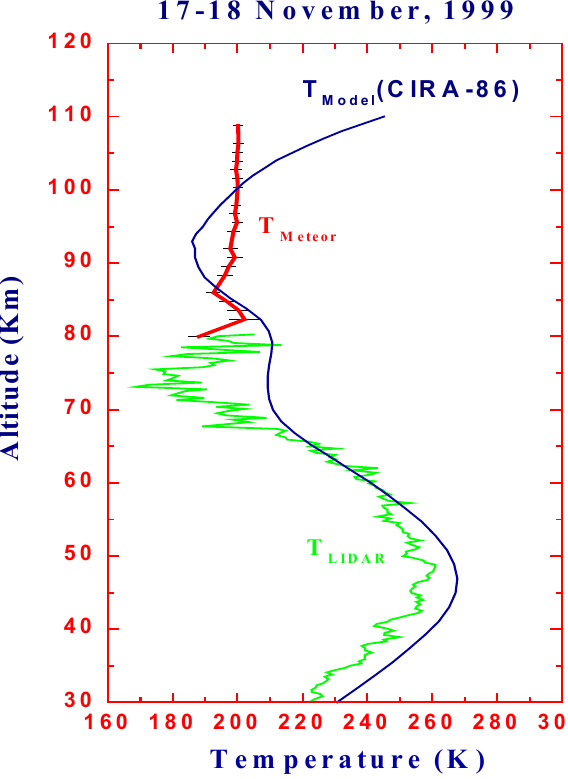
Fig. 6. Day-to-day variation of the lower thermosphere temperature profile.